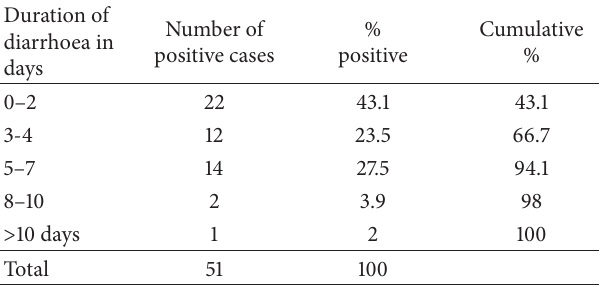
Table 1: Duration of rotavirus diarrhoea in children in Sokoto.